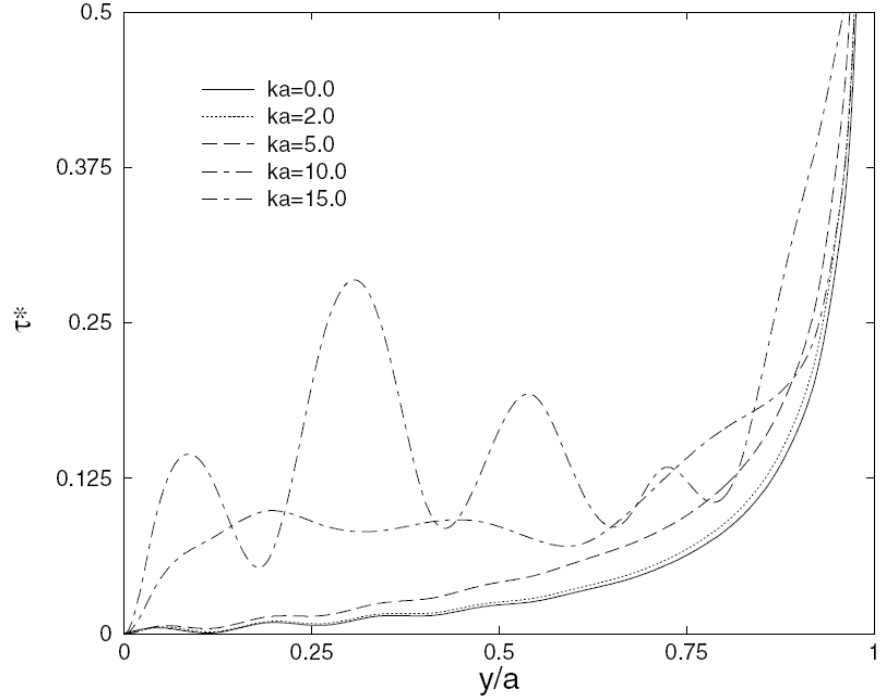
Figure 6. The loading frequency effects on the normalized interfacial shear stress. Taken from Wang and Huang